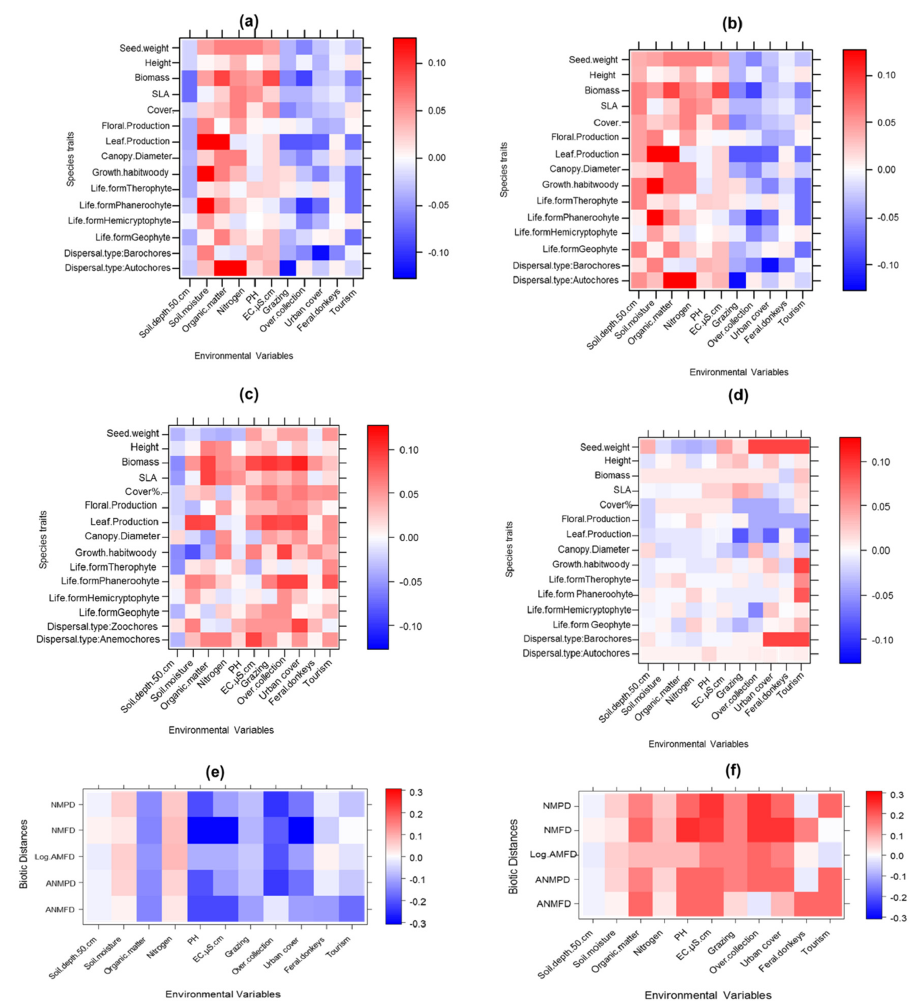
Figure 1. Fourth-corner plots for ( a ) native plants in urban areas ( b ) native plants in non-urban areas ( c ) alien plants in urban areas, and ( d ) alien plants in non-urban areas, ( e , f ) the responses of biotic distances between aliens and natives to the environmental variables in urban and non-urban areas, respectively. Figure shows standardized interaction coefficients for plant species traits on (y-axis) and environmental variables on (x-axis). Note: the abbreviations are: NMPD: native mean phylogenetic distance; NMFD: native mean functional distance; AMPD: alien mean phylogenetic distance; AMFD: alien mean functional distance; ANMPD: alien and native mean phylogenetic distance; ANMFD: alien and native mean functional distance; SLA: specific leaf area (cm 2